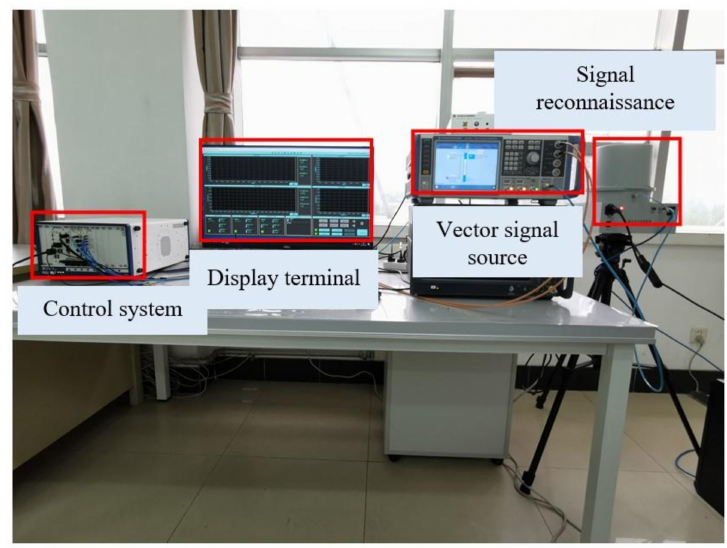
Figure 10. Signal sorting experiment equipment connection diagram.